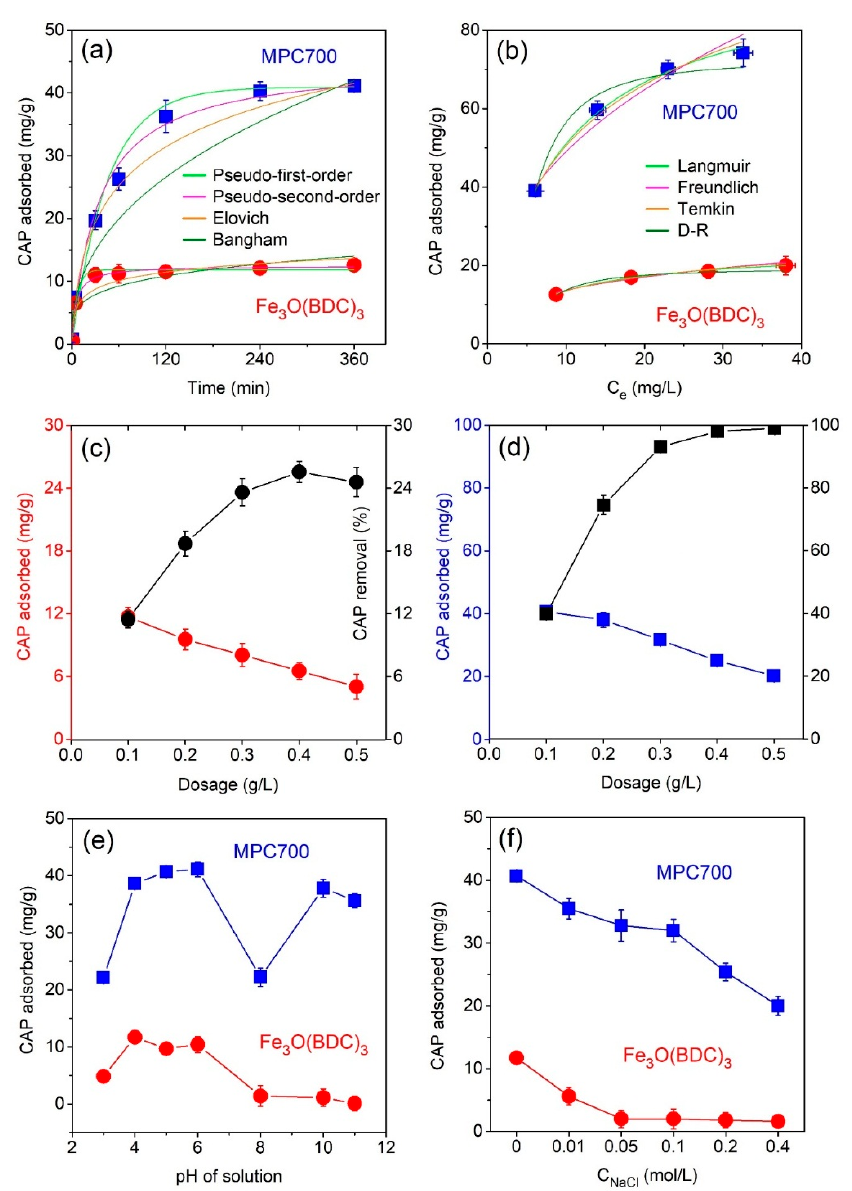
Figure 6. Effect of contact time ( a ); CAP concentration ( b ); adsorbent dosage ( c , d ); pH solution ( d ); and ionic strength ( e ) on the CAP adsorption of Fe 3 O(BDC) 3 and MPC700.